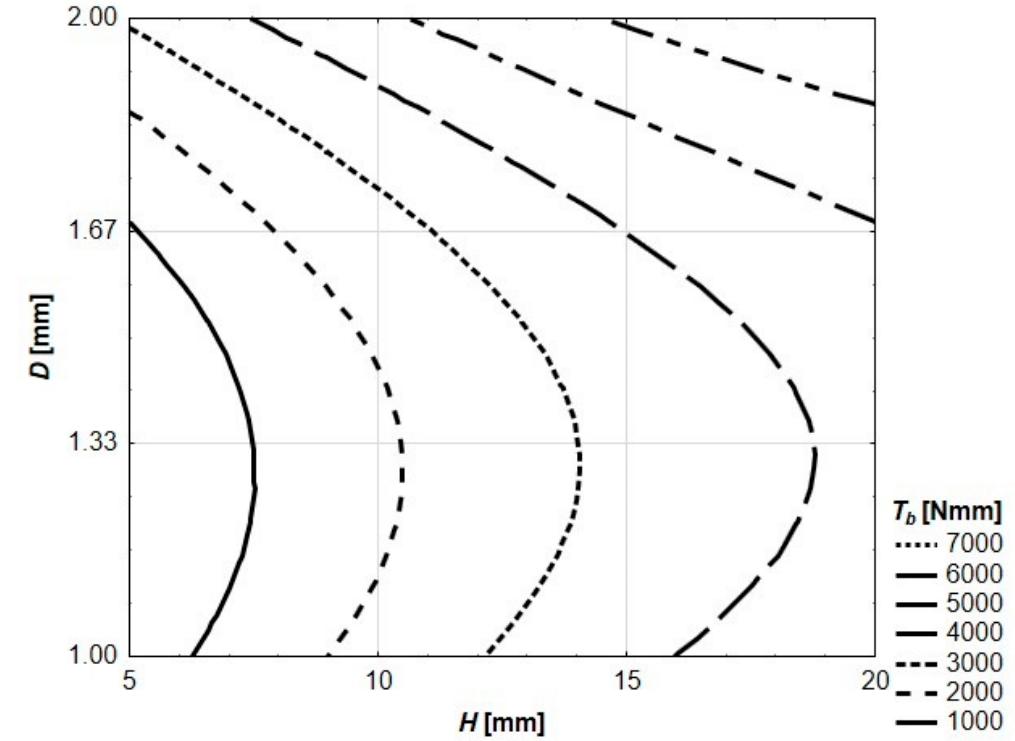
Figure 5. Flexural toughness of tested beams for maximum loading force.